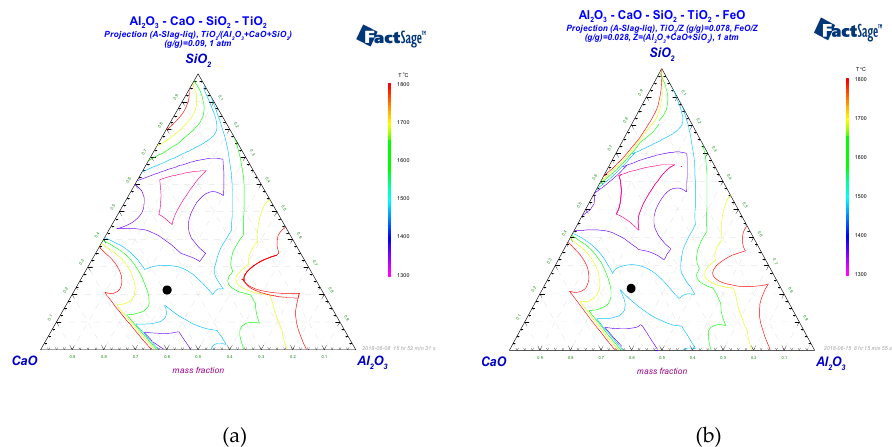
Figure 5. Liquidus projections for ( a ) the CaO-Al 2 O 3 -SiO 2 -8.21 wt % TiO 2 and ( b ) the CaO-Al 2 O 3 -SiO 2 -7.5 wt % TiO 2 -2.5 wt % FeO slag systems (the slag chemical composition is marked by a black dot).